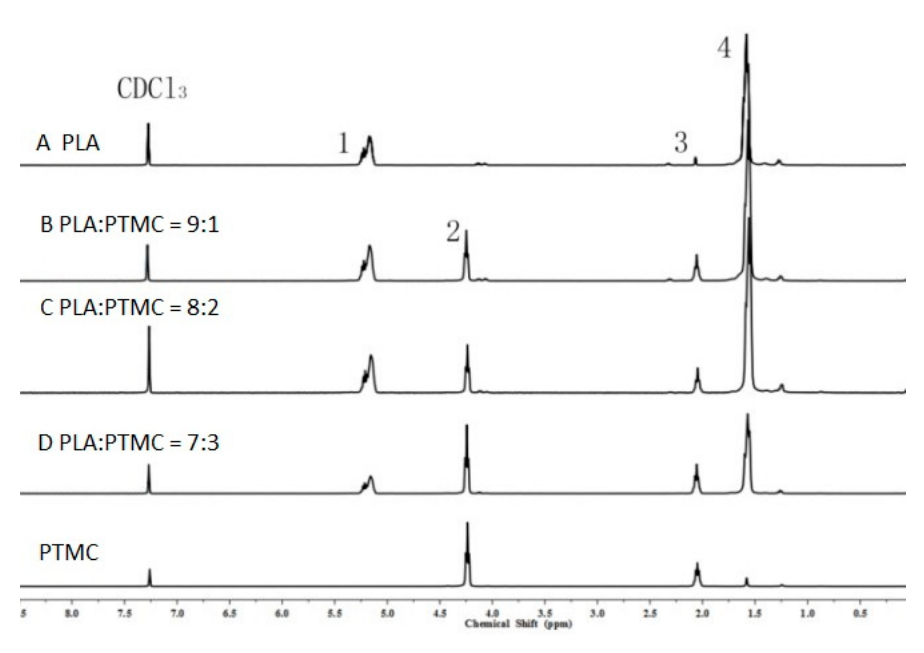
Figure 1. 1 H nuclear magnetic resonance ( 1 HNMR) spectra of poly(lactic acid) (PLA) and poly(trimethylene carbonate) (PTMC) and their blends.